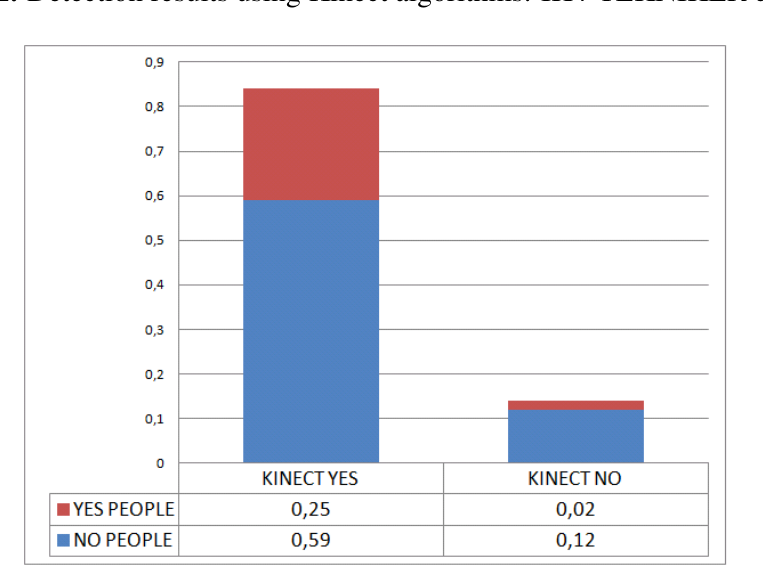
Figure 2. Detection results using Kinect algorithms: IK4-TEKNIKER dataset .